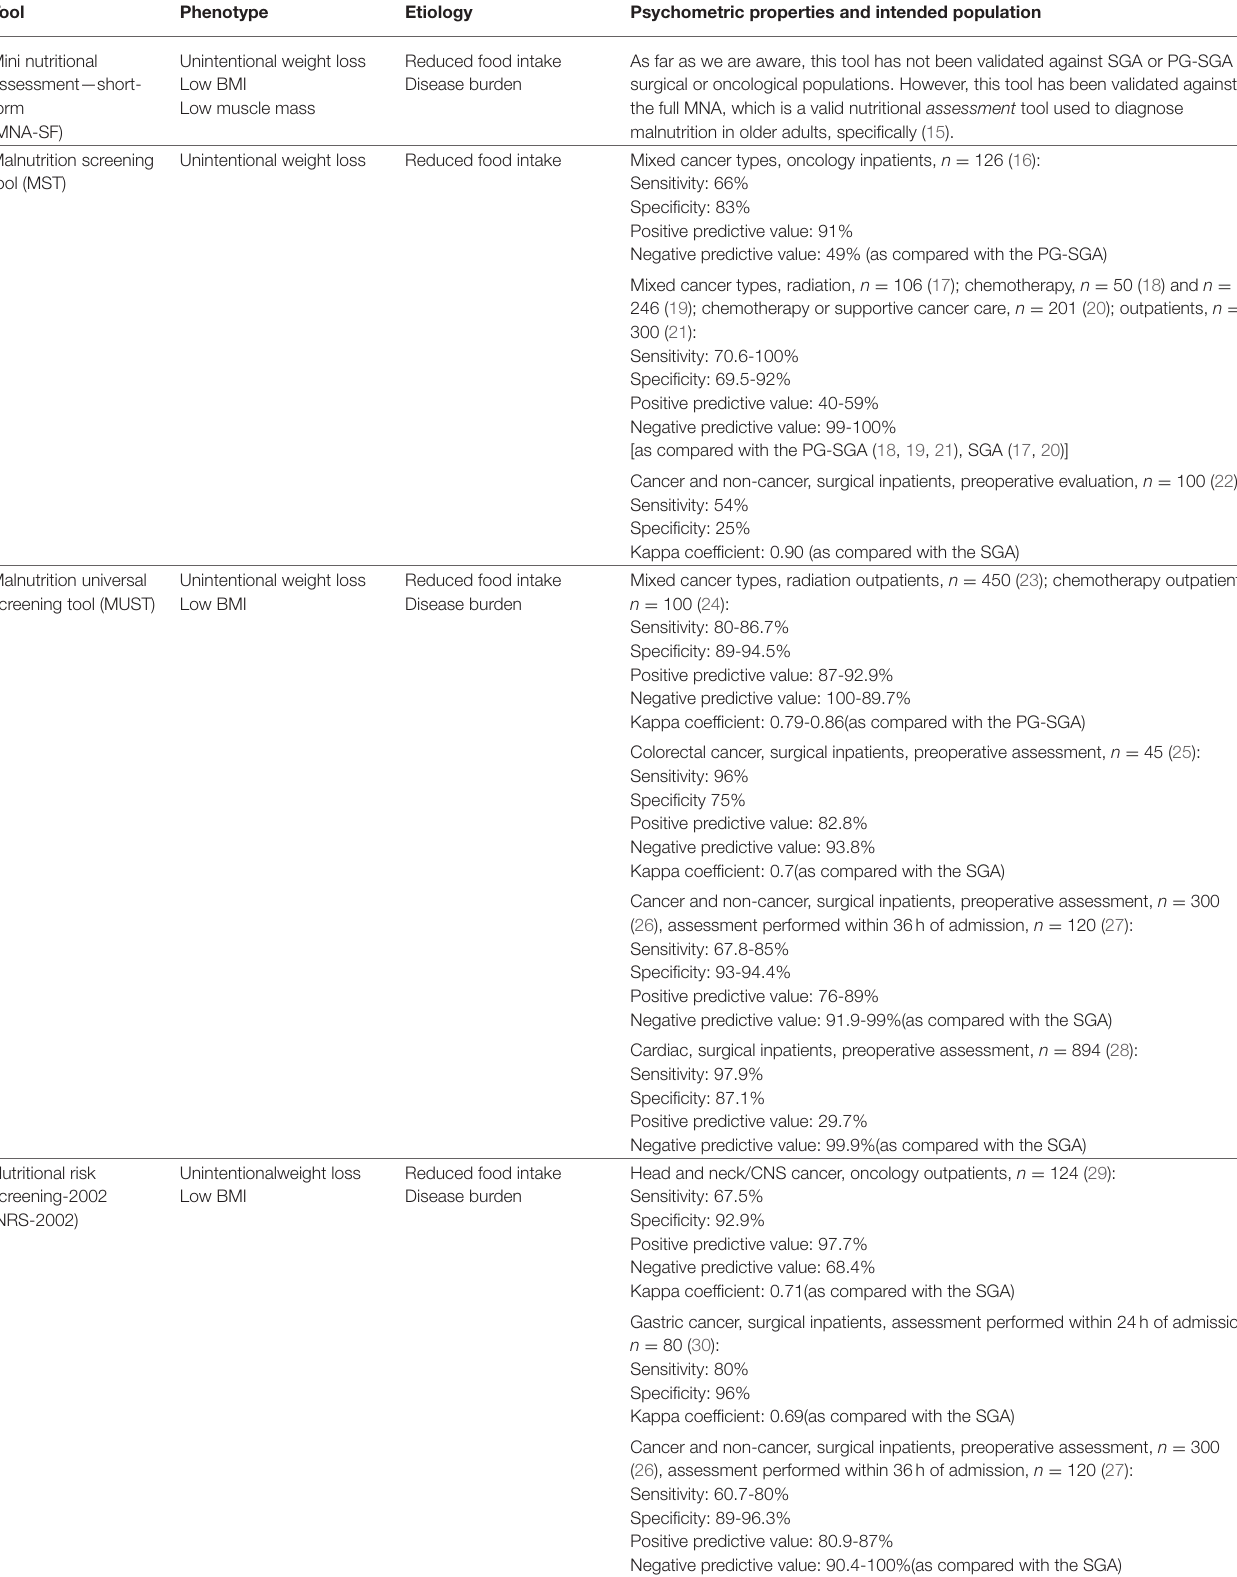
TABLE 1 | A list of nutrition risk screening tools and their psychometric properties for use in oncology and surgical